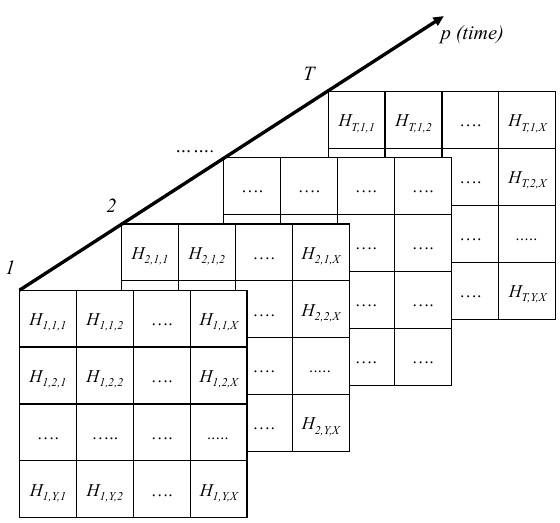
Figure 3. Matrix representation of IUH.